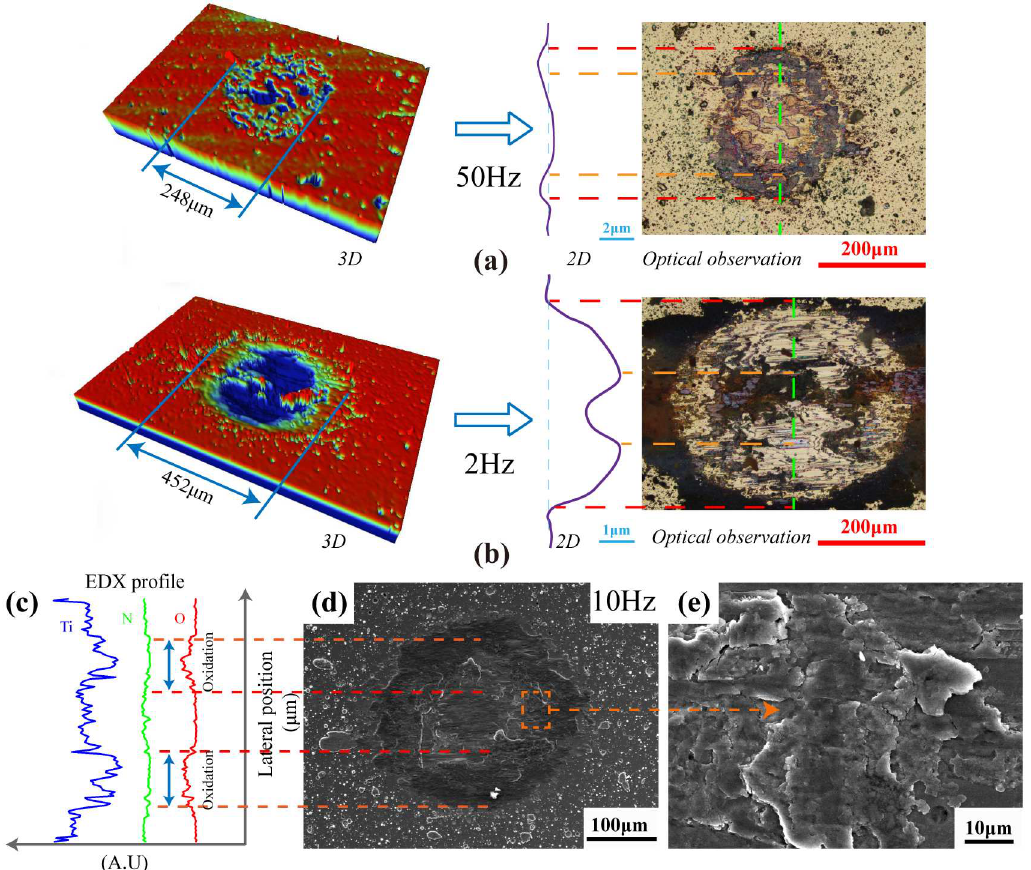
Fig 7. Wear morphology of Ti/TiN multilayer film after the test frequency of 50Hz (a), 2Hz (b) and 10Hz (c).